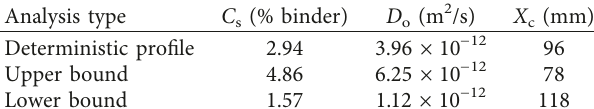
Table 5: Parameters for deterministic assessment. Analysis